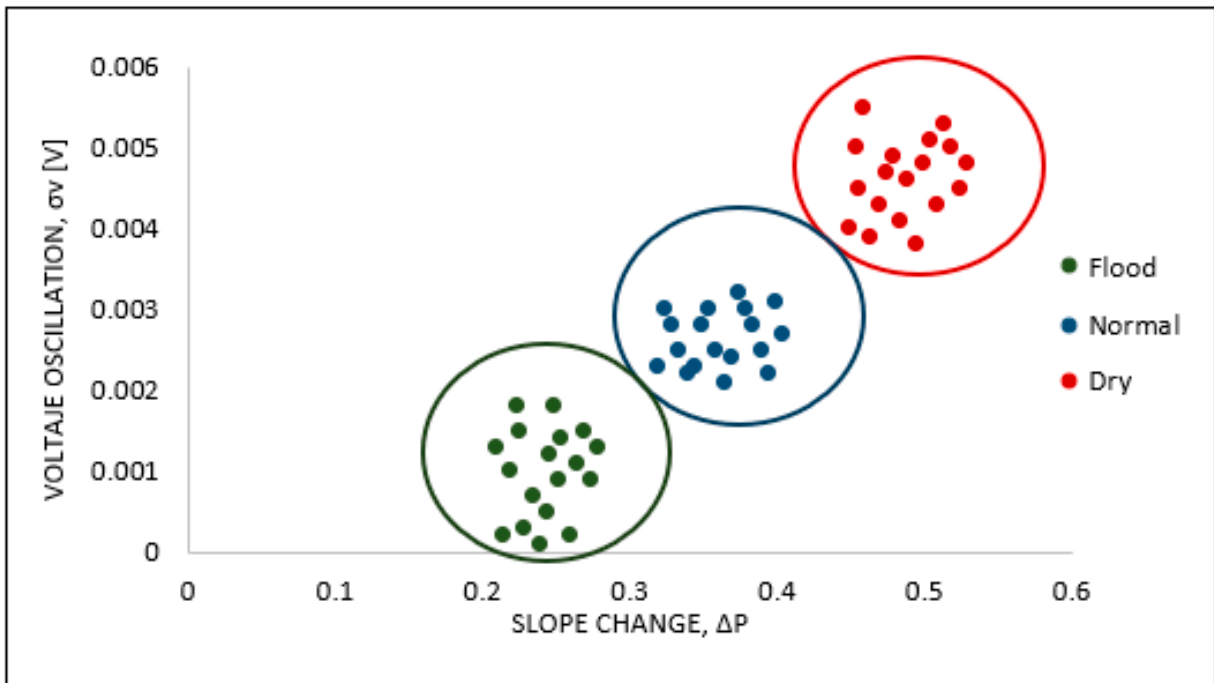
Figure 6. Model for estimating water in PEMFC.